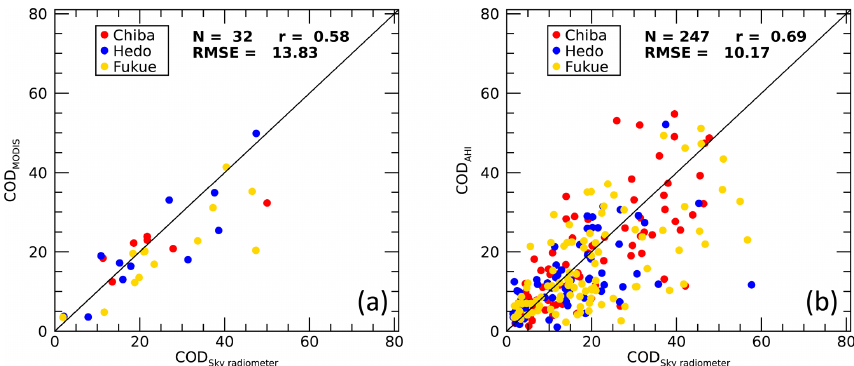
Figure 7. Comparison of sky radiometer cloud optical depths (CODs) with the (a) MODIS and (b) Advanced Himawari Imager CODs for observation sites at Chiba (35.62 ◦ N, 140.10 ◦ E), Hedo-misaki (26.87 ◦ N, 128.25 ◦ E), and Fukue-jima (32.75 ◦ N, 128.68 ◦ E) from Octo- ber 2015 to December 2016.